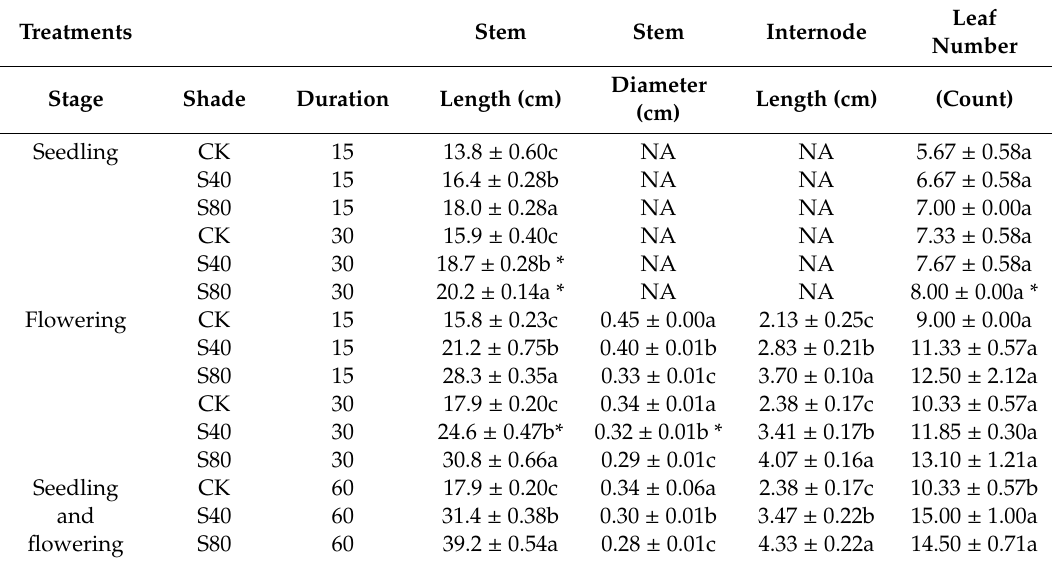
Figure 1. Shading treatment scheme in peanut plants. Table 1. Effects of shade stress on size of peanut plants.